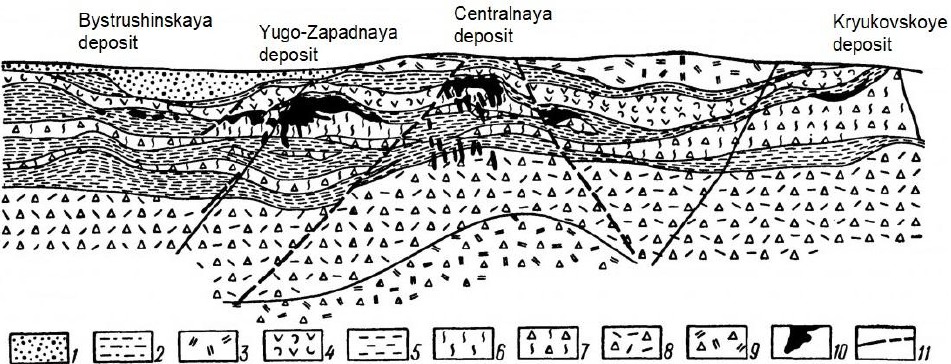
Figure 1. Schematic section of the Ridder–Sokolny deposit. 1—quaternary deposits; Sokolnaya formation: 2—argillite, sandstones; 3—albitophyres; Ilyinskaya formation: 4—tuffs and lavas of medium and basic composition; Kryukov formation: 5—aleuropelites; 6—microquartzites; 7—volcanogenic sedimentary breccias; Leninogorsk formation: 8—lavas of acid composition; 9—breccias; 10—ore bodies; 11—faults [8].